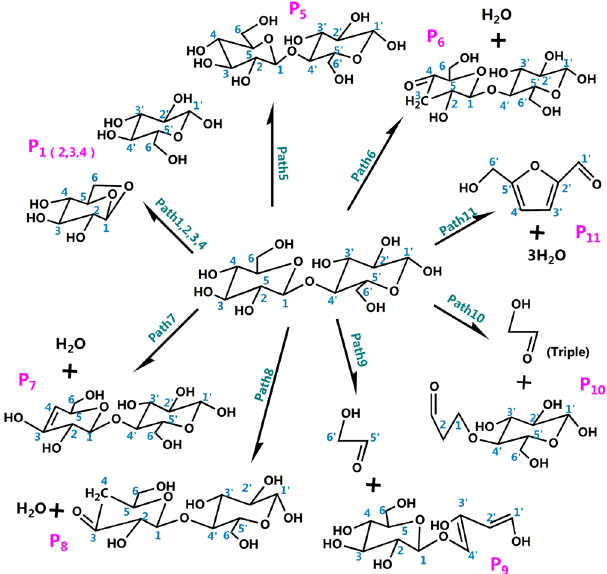
Figure 2. Reaction pathway of cellobiose